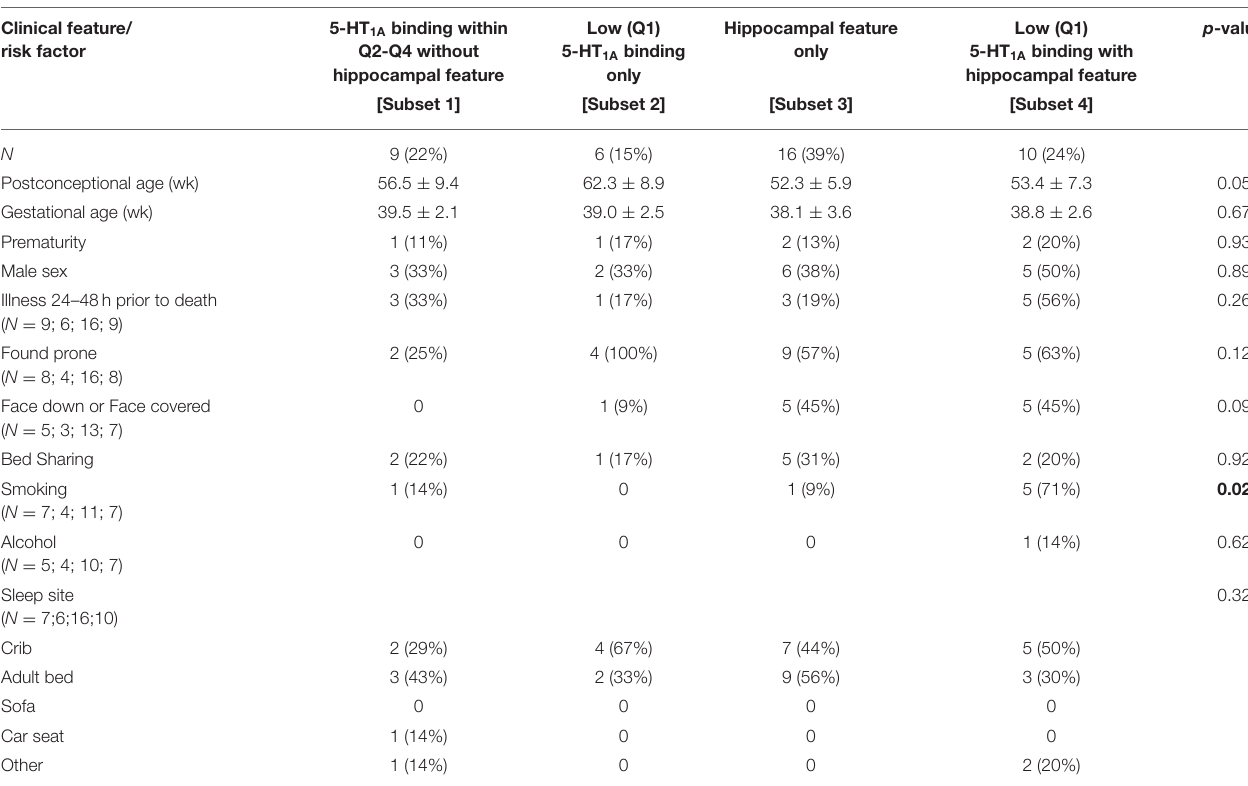
TABLE 9 | Clinical and risk factor profile by medullary 5-HT 1A binding and hippocampal feature (single ectopic granule cells in the molecular layer of the dentate gyrus) status. Clinical feature/ risk